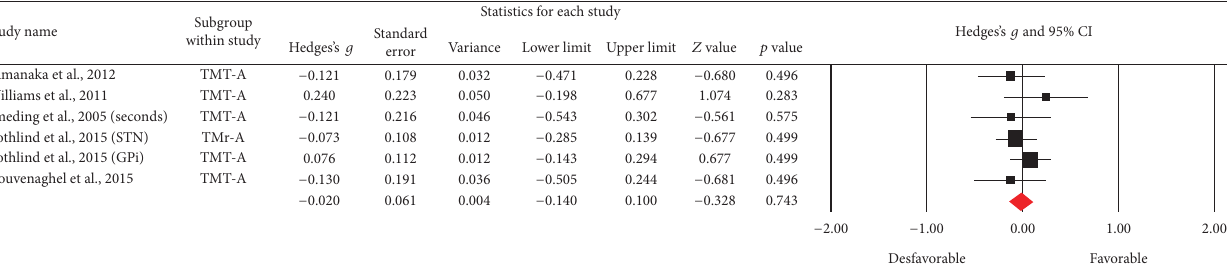
Figure 6: Funnel plot for standard error in publications of Trail Making Test (TMT-A).